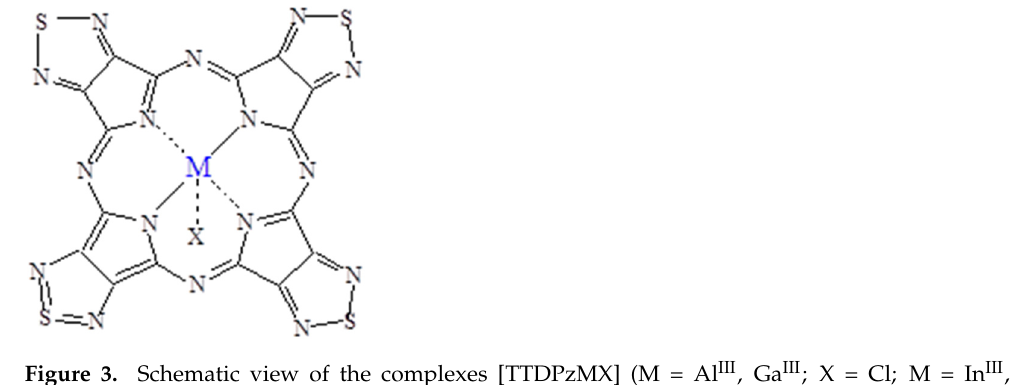
Figure 3. Schematic view of the complexes [TTDPzMX] (M = Al III , Ga III ; X = Cl; M = In III , X = OAc) [5]. Table 1. UV-visible spectral data ( λ , nm (log ε )) of [Py 8 TPyzPzIn(OAc)], [(2-Mepy) 8